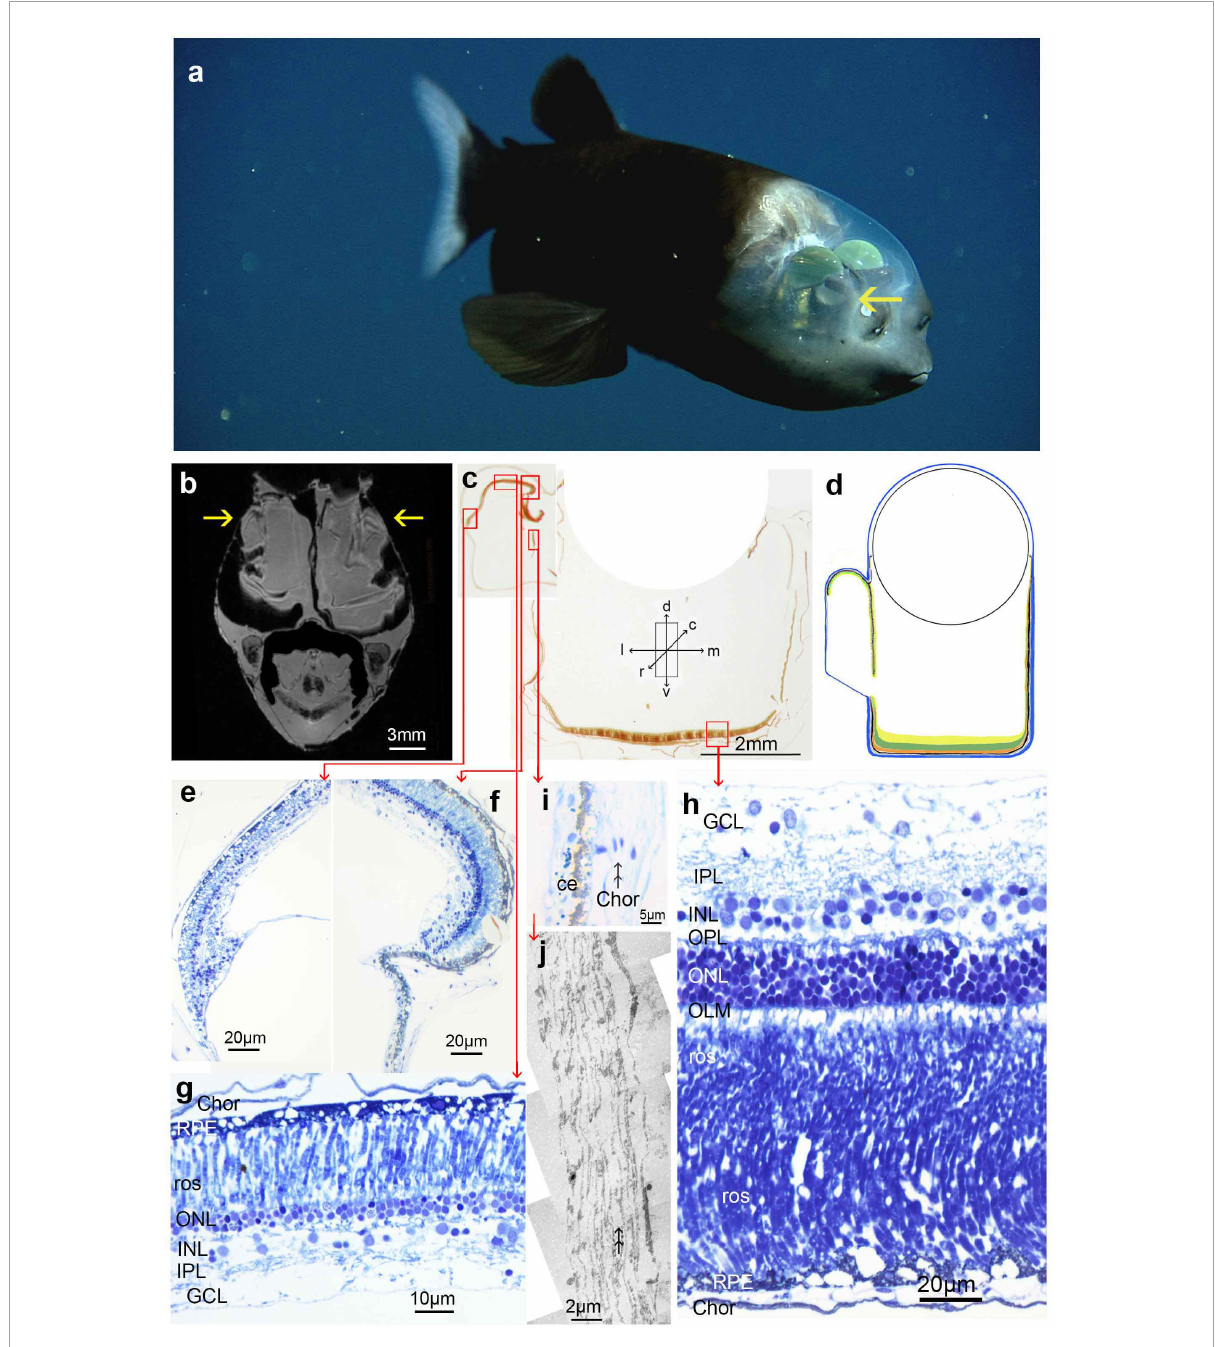
FIGURE8 Larger Macropinna microstoma : (a) image of an animal (SL 110 mm) obtained using an ROV [reproduced from Robison and Reisenbichler (2008) with permission from the American Society of Ichthyologists and Herpetologists]. Arrow indicates the rostrolateral diverticulum; (b) MRI scan in a transverse plane, arrows indicate diverticula; note marked artificial folding of the retina following chemical fixation with aldehydes; (c) approximately transverse thick section of tube eye with lens removed. Due to the poor histology of this animal, the eye is illustrated with a composite of two sections, one of the diverticulum and one of the tubular portion of the eye; (d) schematic drawing of tube eye with diverticulum, colour coded as in Figure 1 ; (e,f) radial semithin sections of the lateral (e) and medial (f) areas of the diverticulum; (g) radial section of the dorsal retina of the diverticulum; (h) semithin radial section of the main retina of the tube eye; (i) radial semithin section of the septum between the diverticulum and the tube eye; (j) radial low power electron micrograph of the septum between the diverticulum and the tube eye; the double arrows in panels (i,j) point at “ghost” spaces where reflective crystals (likely guanine) lost during preparation may have been located. The orientation arrows in panel (c) are also applicable to panels (d–h) but see Materials and Methods for comments on deviations from the transverse plane in histological sections. All images in this figure came from an animal of SL 55 mm, except for the animal shown in panel (a)